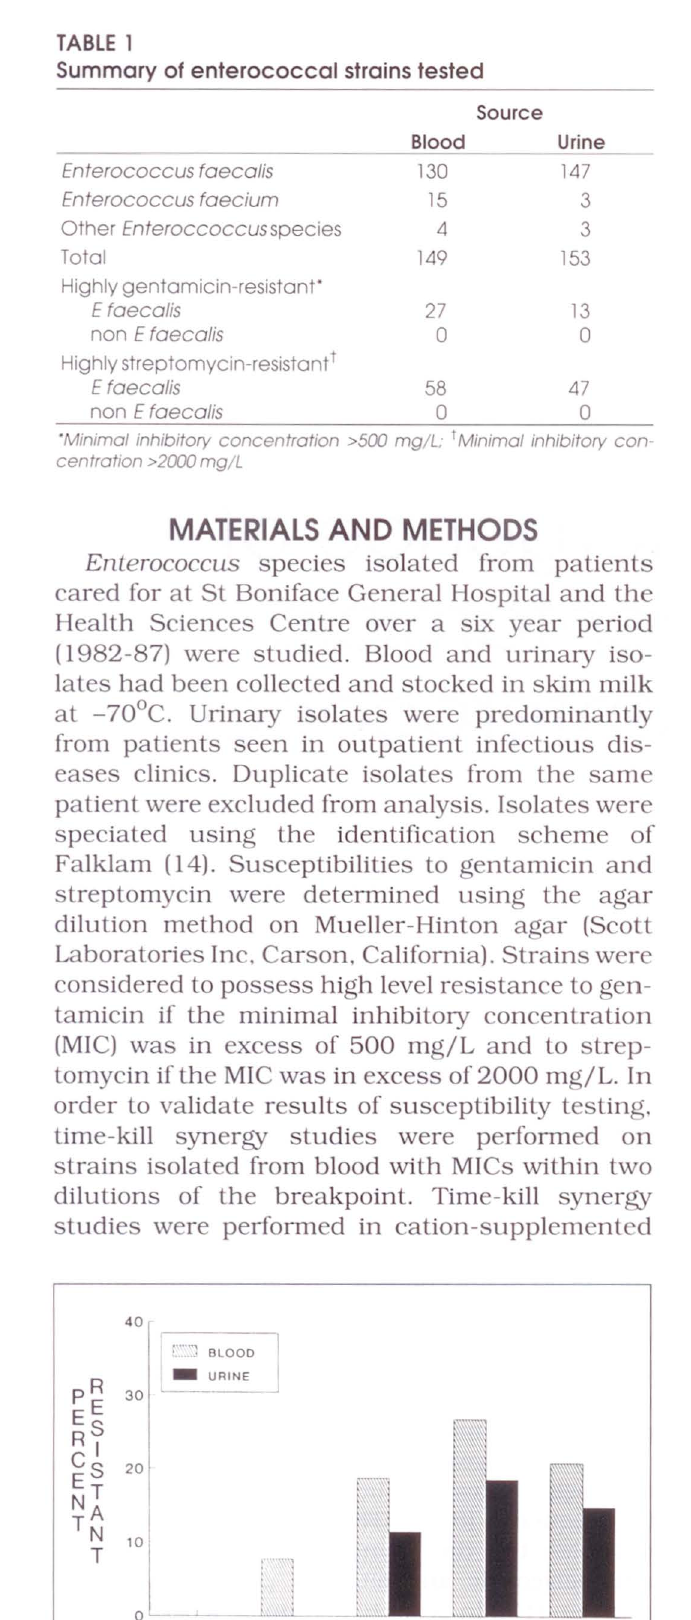
Figure 1) Percentage of Enterococcus species strains isolated from blood or urine and highly resistant to gentamicin (left) (minimal inhibitory concentration >500 mg/L) or streptomycin (right) (minimal inhibitory concentration >2000